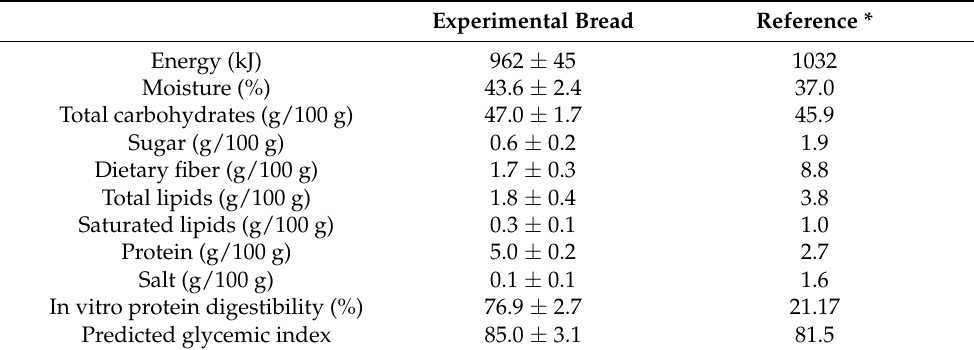
Table 6. Proximate composition and nutritional evaluation of the experimental “clean-label” gluten- free (GF)